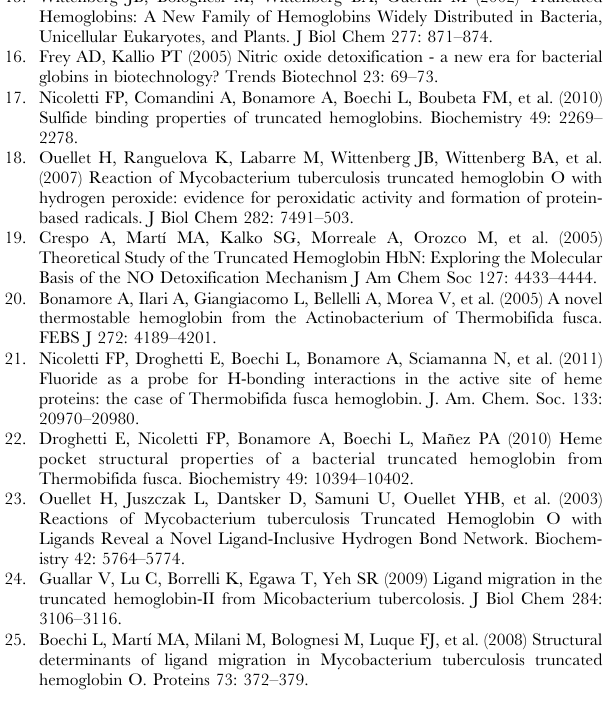
Figure S5 Change in CO concentration in solution as estimated from the analysis of the rebinding kinetics reported in Figure 9 of the article. Green, simulation of CO concentration, red, fitting with a double exponential rise. (TIF) Figure S6 CO rebinding kinetics at l PROBE = 435 nm after photolysis with femtosecond pulses; l l PUMP = 400 nm (thick black line) and PUMP = 560 nm (thin red line). The signals are normalized to 1 to the maximum of the intensity. Although the different quality of the results, we can assert that the kinetic profiles are not affected by the excitation wavelength. The behavior observed in the horse heart myoglobin has been also shown in the figure in order to highlight the presence of the ultrafast rebinding component in Tf -trHb. The curve taken in Tf -trHb after excitation at 400 nm has been fitted with a mono- exponential decay function: the time constant results equal to 3.9 ns. It decreases to 2 ns if we include a nonzero asymptotic contribution, kept fixed to 0.38 corresponding to the bimolecular dissociation yield (LFP experiments).